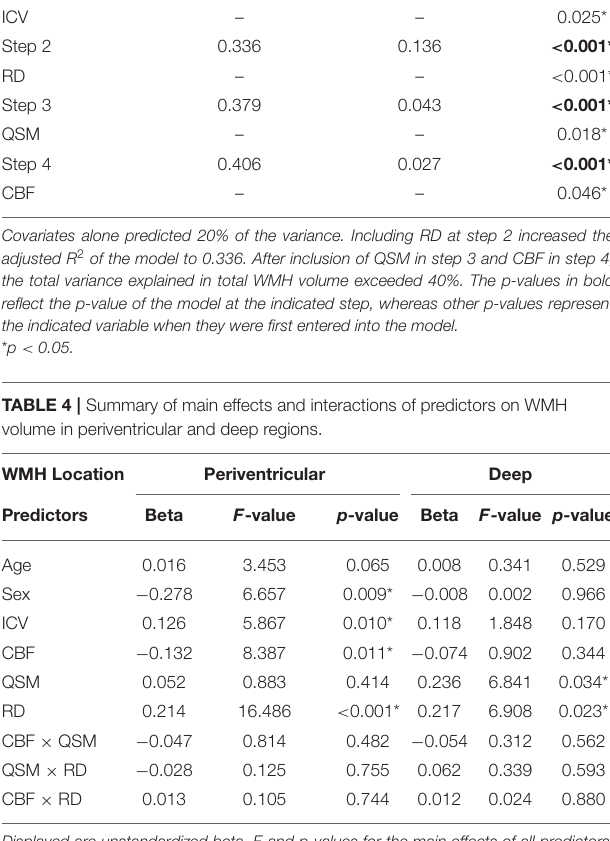
Displayed are unstandardized beta, F-and p-values for the main effects of all predictors, and interaction effects inbothPV(left) and deep (right)WMHmodels. QSMwaspositively associated with deep but not PV WMH volume, while RD strongly predicted both. CBF negatively predicted PV WMH volume. There were no interactions between predictors in either model. * p <